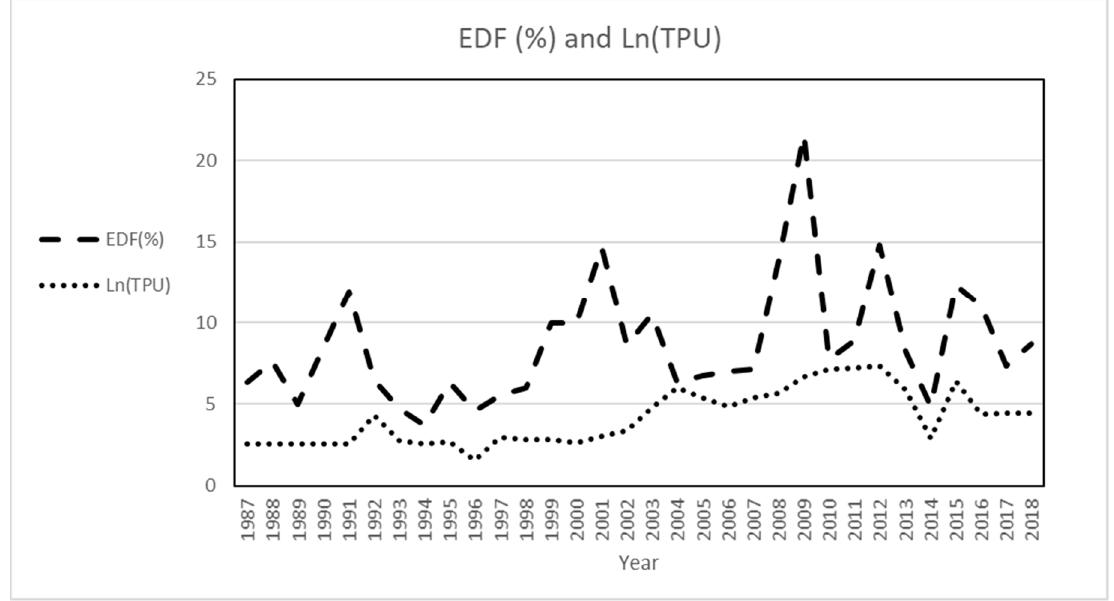
Figure 1. The figure plots cumulative EDF (%) and ln(TPU) during the sample period from 1987 to 2019. Source: Computed by the authors.